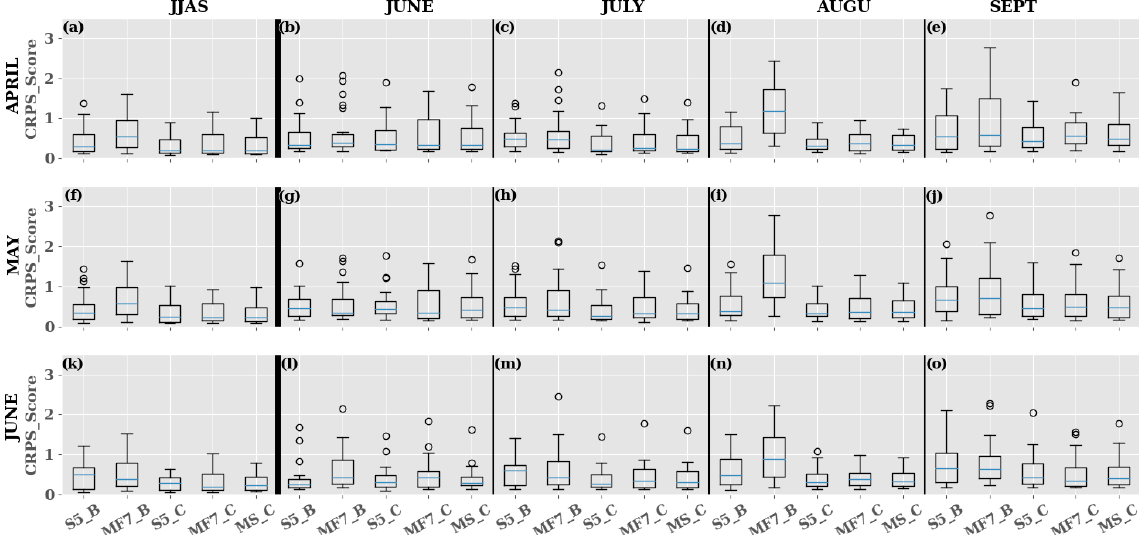
Figure 12. Evaluation of the interannual variability in the SHL over the JJAS period and separately in June, July, August and September during 1993–2016 using monthly mean T850 over the central SHL box at different initialization months: (a–e) April, (f–j) May and (k–o) June. S5_B and S5_C represent respectively the CRPS evaluated using the SEAS5 raw and corrected forecast respectively with the CDF-t method. The same applies for MF7_B and MF7_C with the MF7 model. MS_C represents the CRPS evaluated on the multi-model formed by SEAS5 and MF7 corrected forecasts with the CDF-t method. The computation was made using the ensemble member for both corrected and raw forecasts. The y axis indicates the CRPS values and x axis the data type used for the computation of the